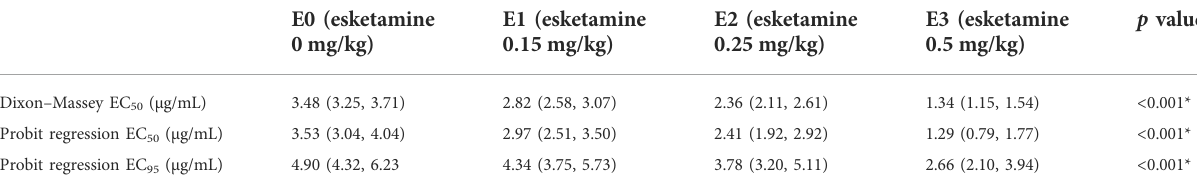
TABLE 3 EC 50 and EC 95 with 95% con fi dence intervals of propofol in four groups, based on the Dixon – Massey Up-and-Down Sequential Allocation Method and Probit Regression respectively. EC 50 , effective concentration in 50% of patients. EC 95 , effective concentration in 95% of patients. * p < 0.001 was considered signi fi cantly different between